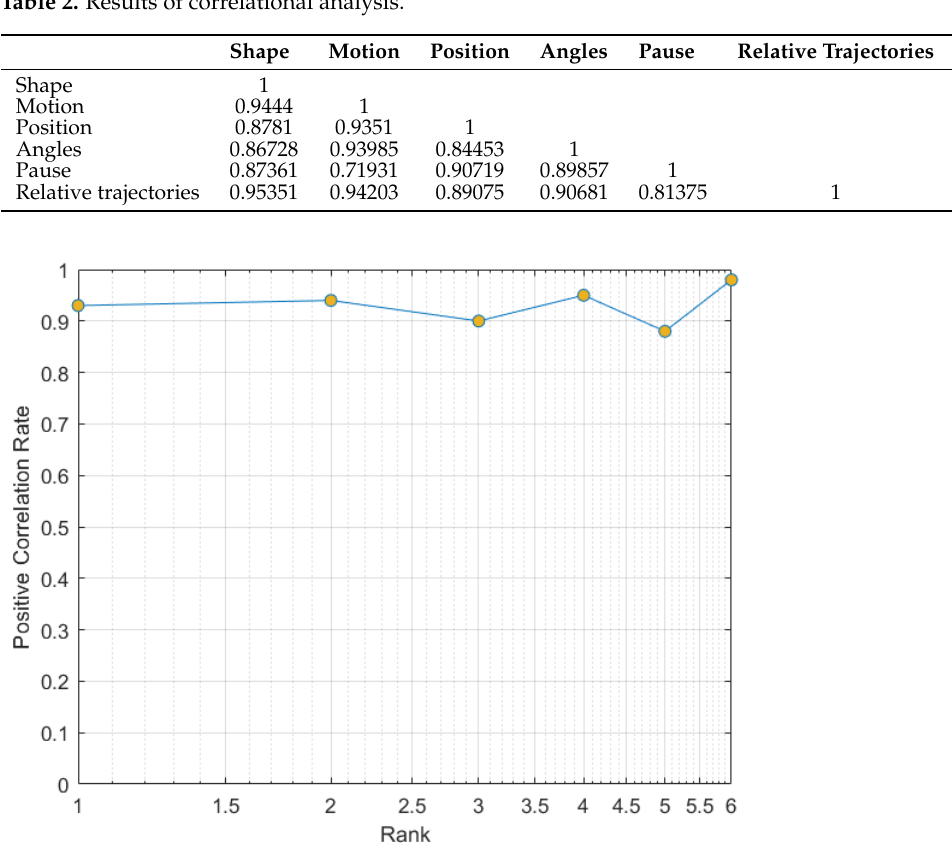
Table 2. Results of correlational analysis.